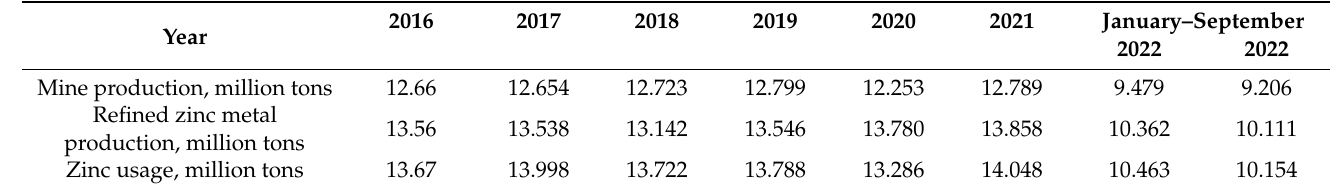
Table 3. World zinc production and usage in years 2016–2022, working out based on